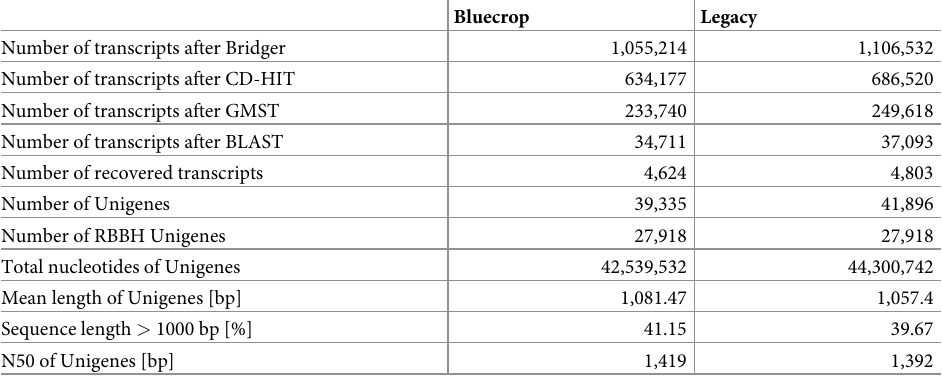
Table 2. Summary of the transcript data and assembled unigenes for the ’Bluecrop’ and ’Legacy’